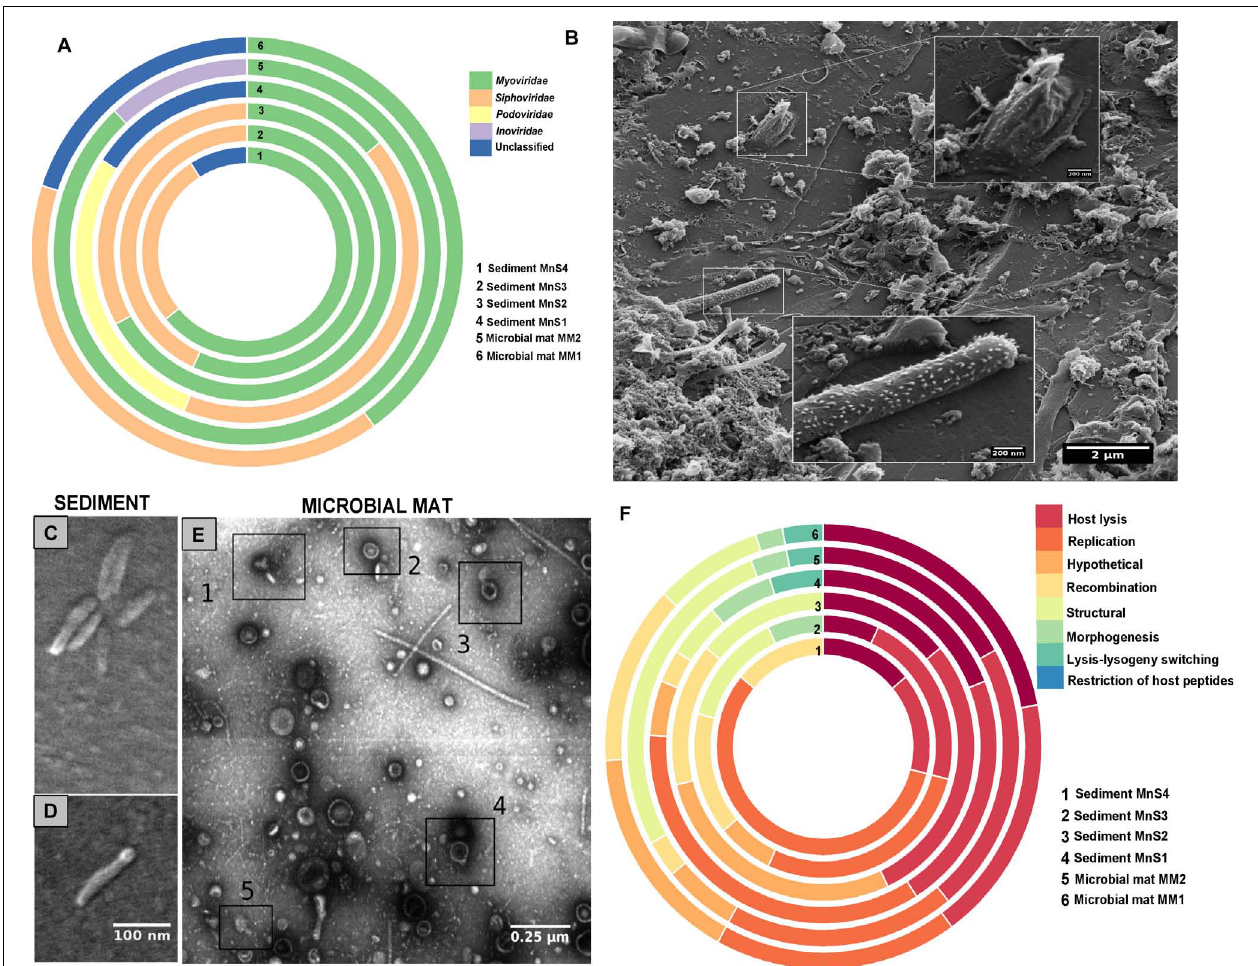
FIGURE 1 | (A) Stack graph showing relative abundance (%) of Caudovirales phages reconstructed across sediment (MnS1, MnS2, MnS3, MnS4) and microbial mat samples (MM1 and MM2). (B) The scanning helium-ion micrographs display typical areas of the microbial bio-films found in the sediment. Sediment is microbial deposition found around the thermal discharges at depth of 10 cm from the surface where the hot spring water flows out. These samples show that phage/virus infected bacteria were found. The insets in (B) show the viral particles as well a dead host cell in the vicinity. (C,D) Scanning electron micrographs of viruses enriched from sediment samples showing spindle shaped archaeal viruses with identical scale bar. (E) Scanning transmission electron micrograph of phages enriched from the mat samples showing different morphotypes: 1. Myoviridae , 2. Tailless phage, 3. Tailless phage head, 4. Siphoviridae , 5. Podoviridae . All the images were collected at electron energy of 10 kV and a beam current of 250 pA. (F) Stack graphs showing relative abundance of eight categories of functional genes annotated from Caudovirales phages reconstructed across sediment (MnS1, MnS2, MnS3, MnS4) and microbial mat samples (MM1 and MM2). The eight broad functional categories were formed from 99 orthologous genes identified in the reconstructed genomes using the Hidden Markov Model (HMM) profiles for orthologous genes from